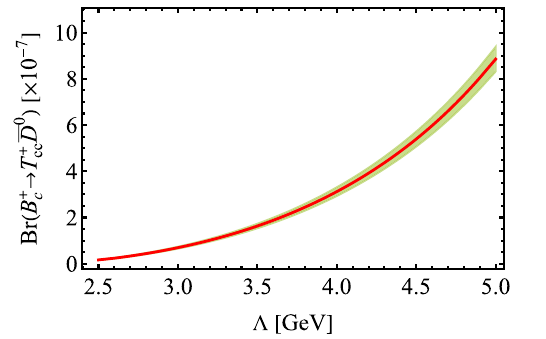
Fig. 3 (cid:6) -dependence of the branching ratio of B + c → T + cc ¯ D 0 via the rescattering processes in Fig. 1. The band is obtained by taking into account the uncertainties of g 1 and g 2